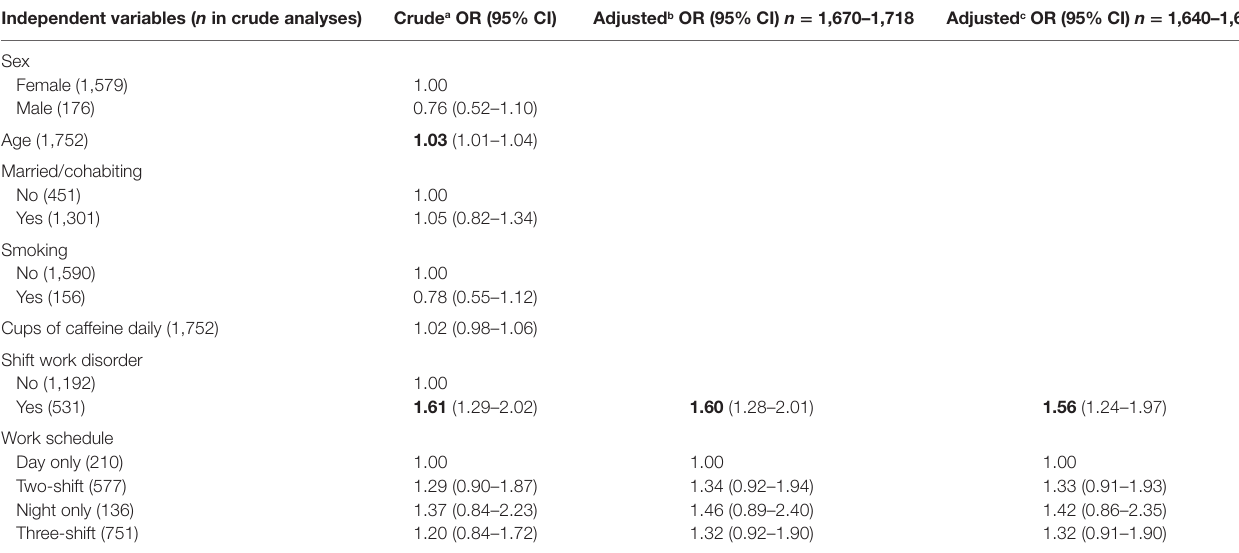
TaBle 3 | Logistic regression analyses with RLS/WED as the dependent variable among shift working nurses in Norway ( n = 1,788). independent variables ( n in crude